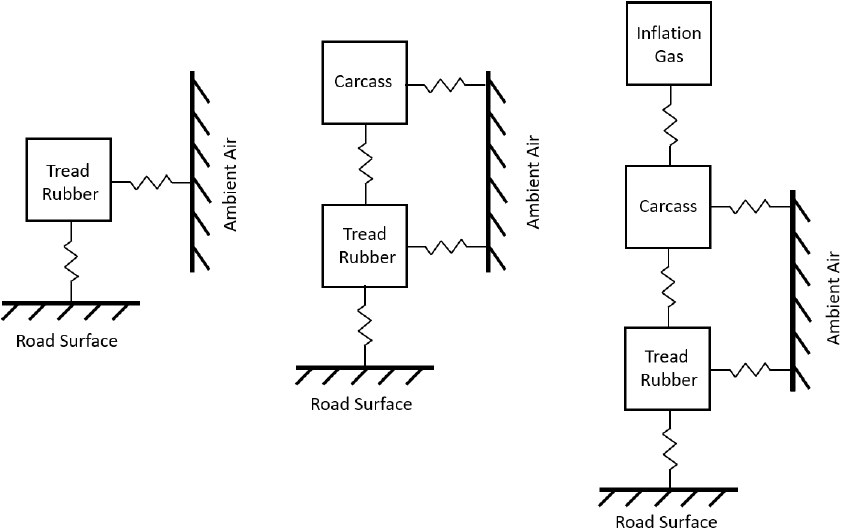
Figure 3. One, two, and three-node lumped thermal model schematics, as presented in [6,21,22],